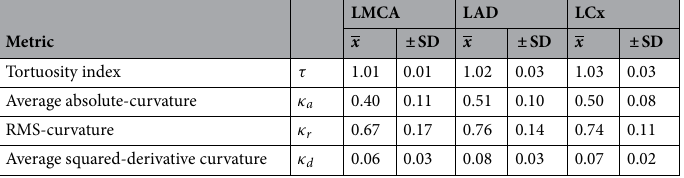
Table 2. Mean ( x ) and SD values of tortuosity metrics studied in 127 left main